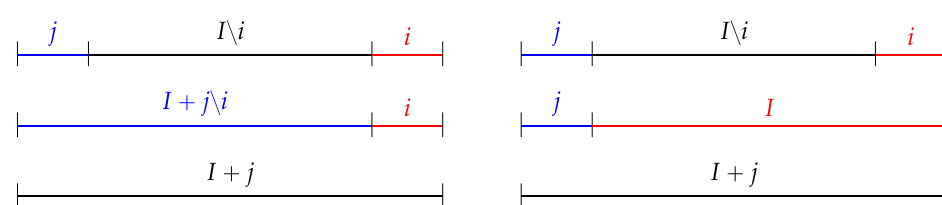
Figure A3. Visual aid for the identity σ p j , I z i q σ p I ` j z i , i q “ σ p I z i , i q σ p j , I q